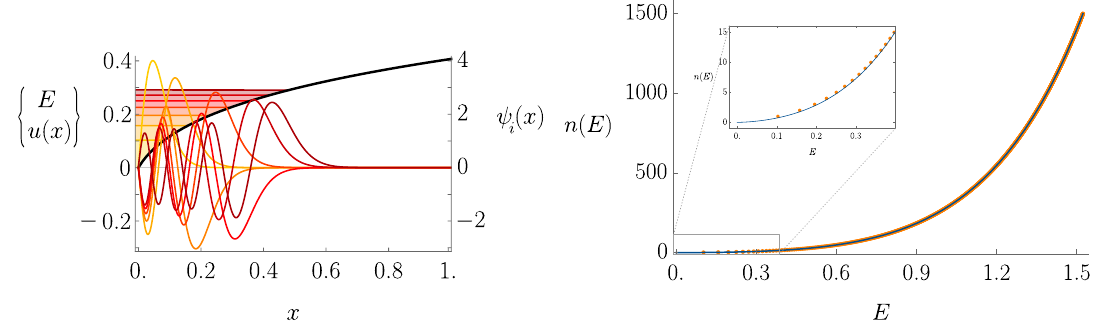
Figure 4 . Left: first seven normalized eigenstates ψ i ( x ) and energies of b Q for S 0 = 5 . We also plotted the potential u ( x ) in black. The more red the coloring the higher the energy. The left vertical axis is for E i and u ( x ) , whereas the right one is for ψ i . Right: integrated spectral density n ( E ) = (cid:1) E ρ ( E 0 )d E 0 for the first 1500 eigenvalues of H JT (orange dots) and the JT gravity result 0